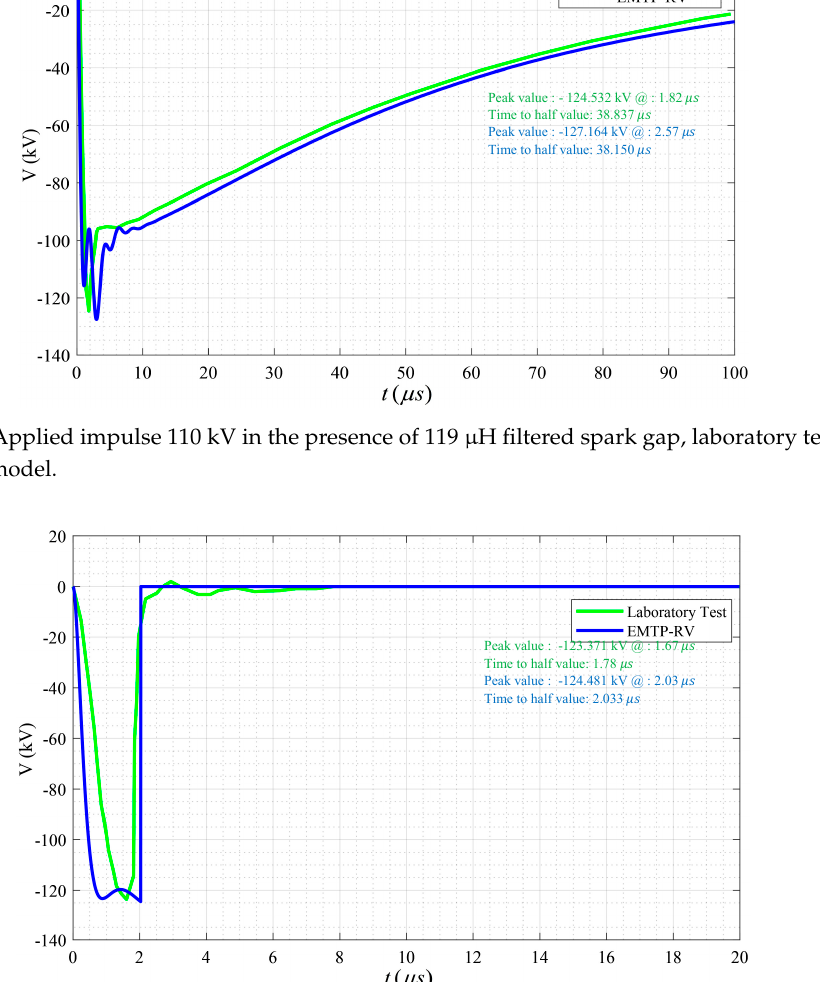
Figure 15. Applied impulse 125 kV in the presence of the 35 µ H filtered spark gap, laboratory test and EMTP-RV model.